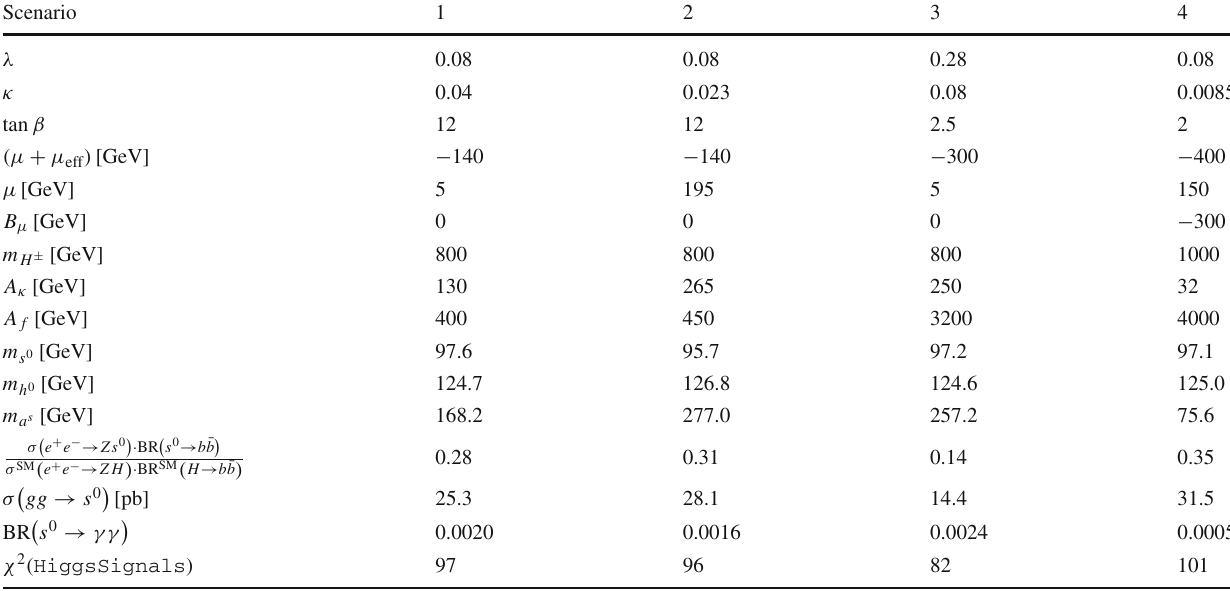
Table 2 Scenarios that yield a light CP -even singlet-like Higgs boson. The Higgs boson at about 125GeV is SM-like. All other parameters are chosen in accordance to Table